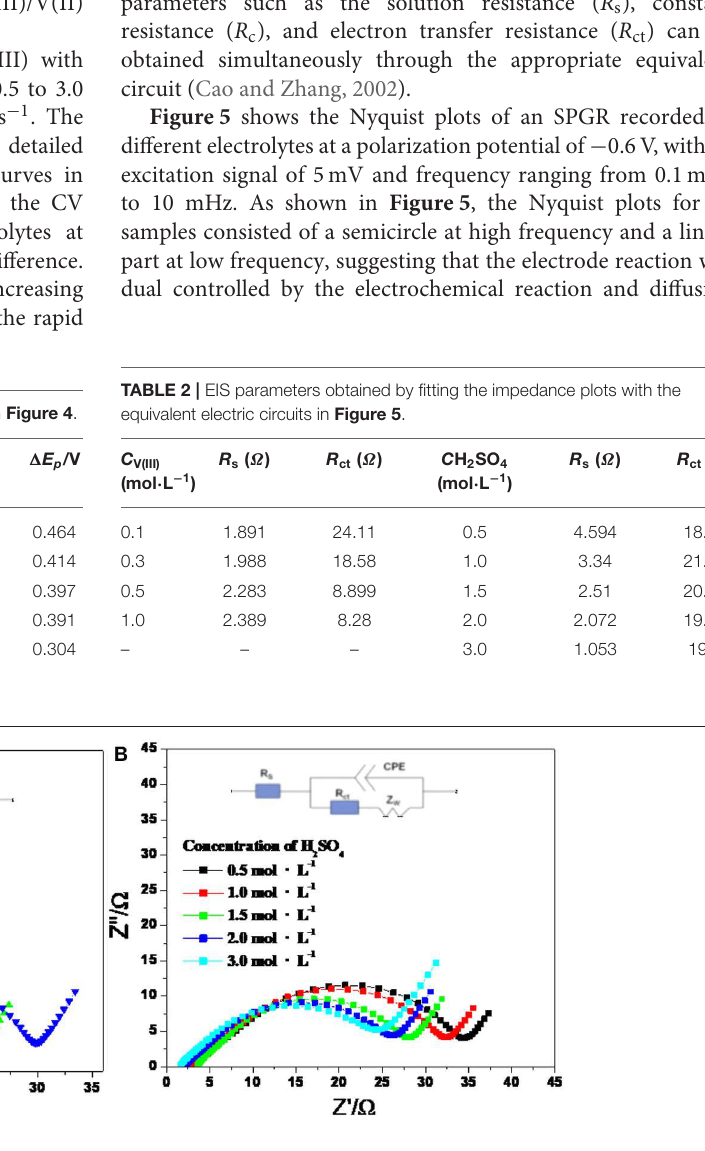
FIGURE 5 | Nyquist plots and the equivalent electric circuit of V(III)/V(II) redox couples with 2.0 mol · L − 1 H 2 SO 4 electrolyte with different concentrations of V(III) (A) and 0.1 mol · L − 1 V(III) electrolyte with different concentrations of H 2 SO 4 (B) at a polarization potential of − 0.6V.